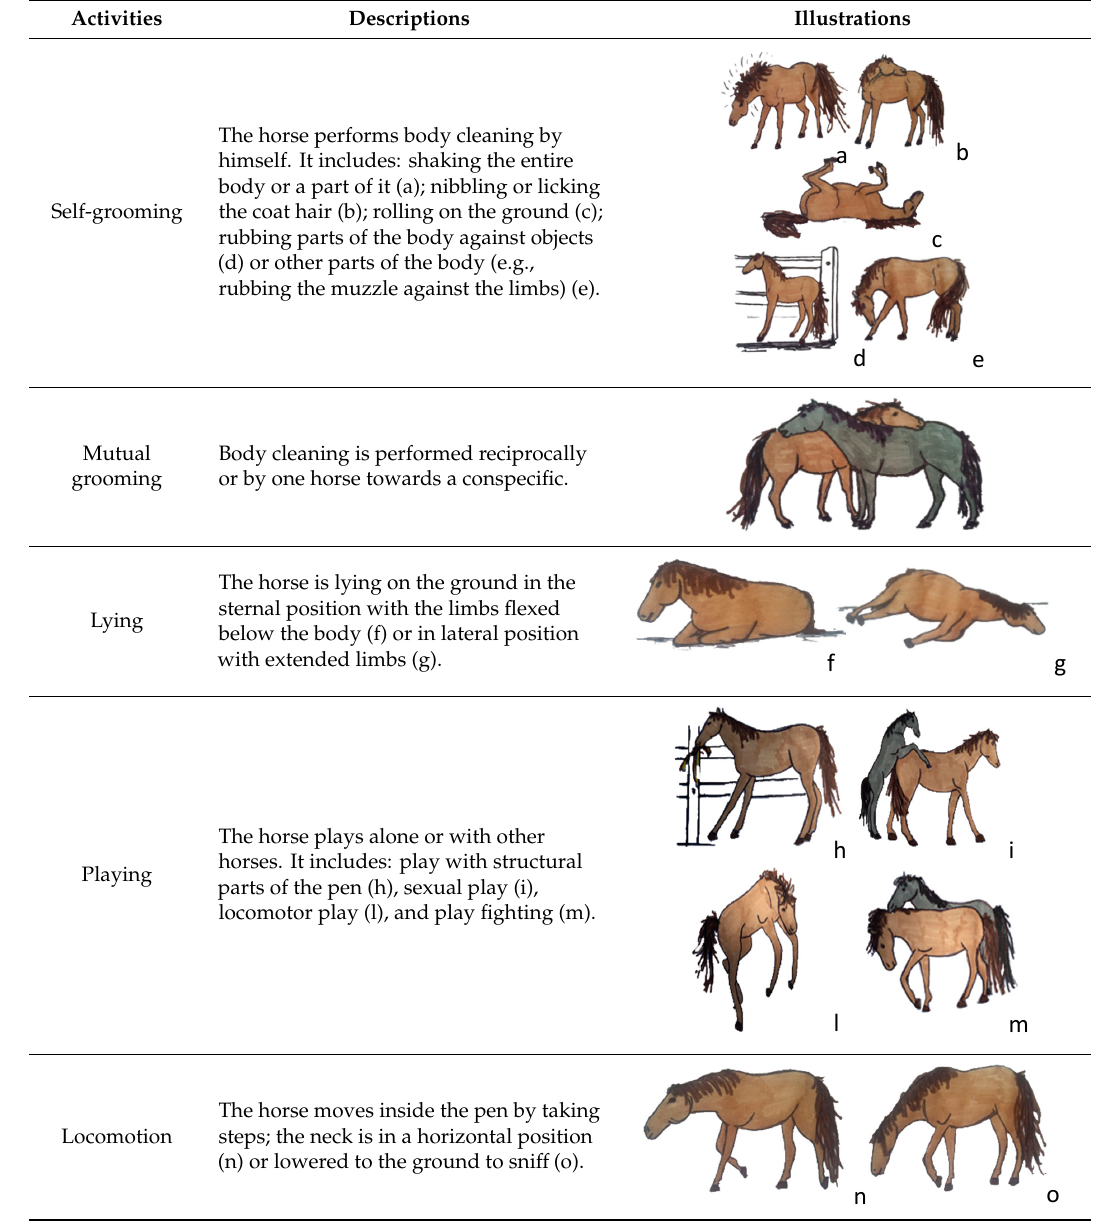
Table 2. Description and illustrations of the selected mutually exclusive behaviour activities.